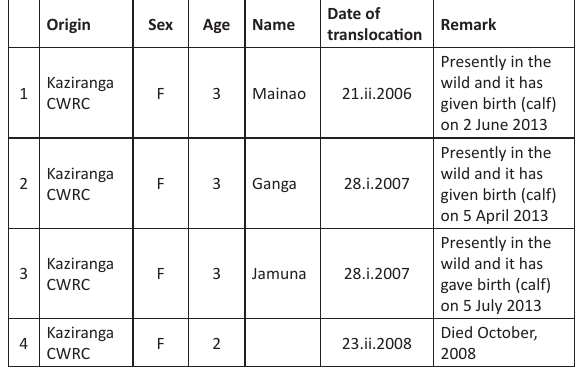
CWRC ‐ Centre for Wildlife Rehabilitation and Conservation